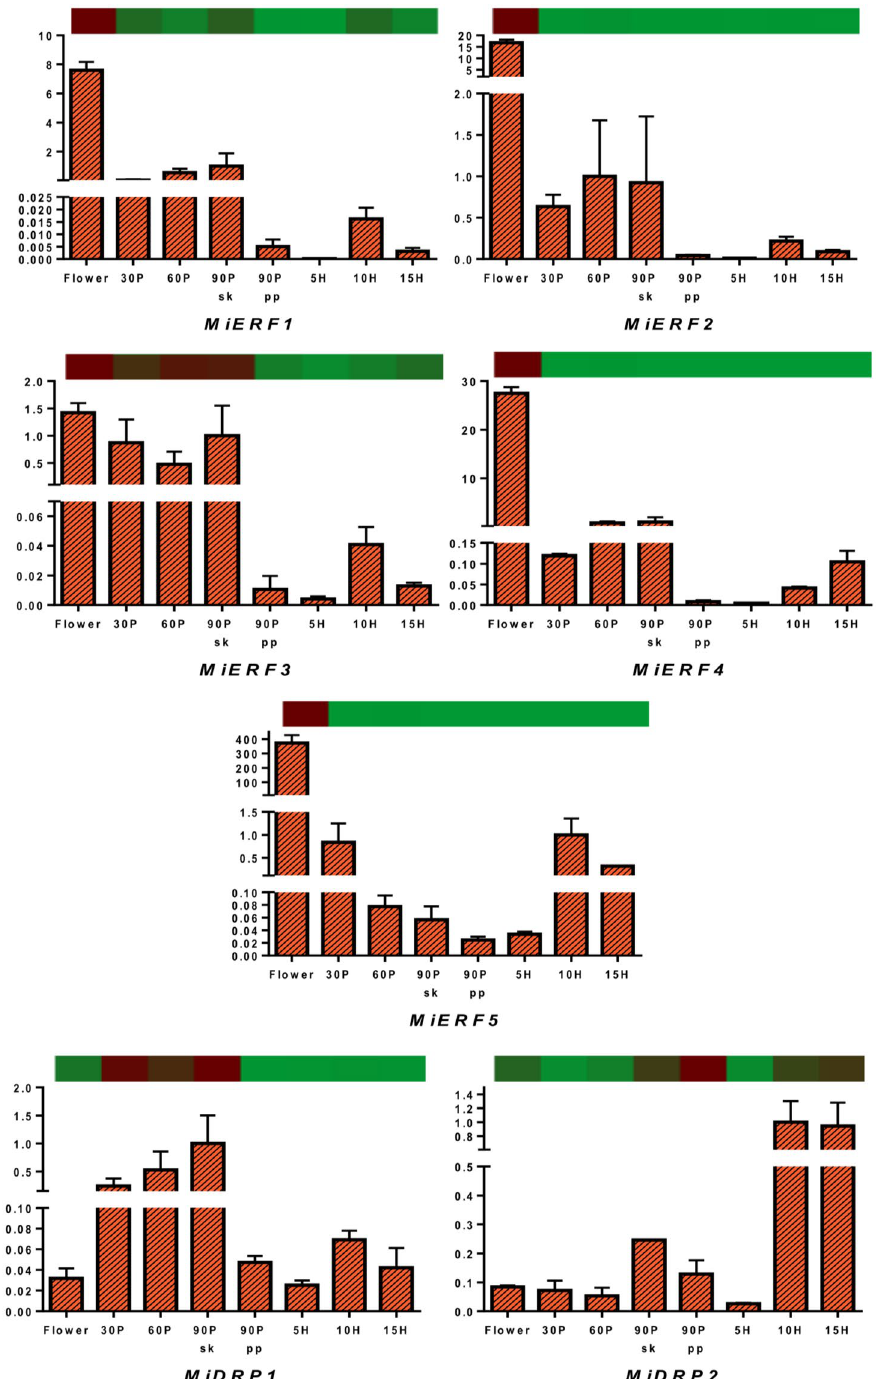
Figure 7. Quantitative reverse-transcriptase PCR validation of various transcripts obtained through RNAseq from ethylene responsive factors (ERF) and disease resistance proteins (DRP) through various tissues (flower and fruit developing and ripening stages). Vertical bars at each data point represent standard error in the relative quantification among the three biological replicates. X-axis represents fruit development and ripening stages and Y-axis represents relative transcript abundance. The horizontal bar above each histogram represents the expression level of the same transcript as obtained through RNAseq analysis, wherein dark-red color indicates higher expression and light-green color indicates lower